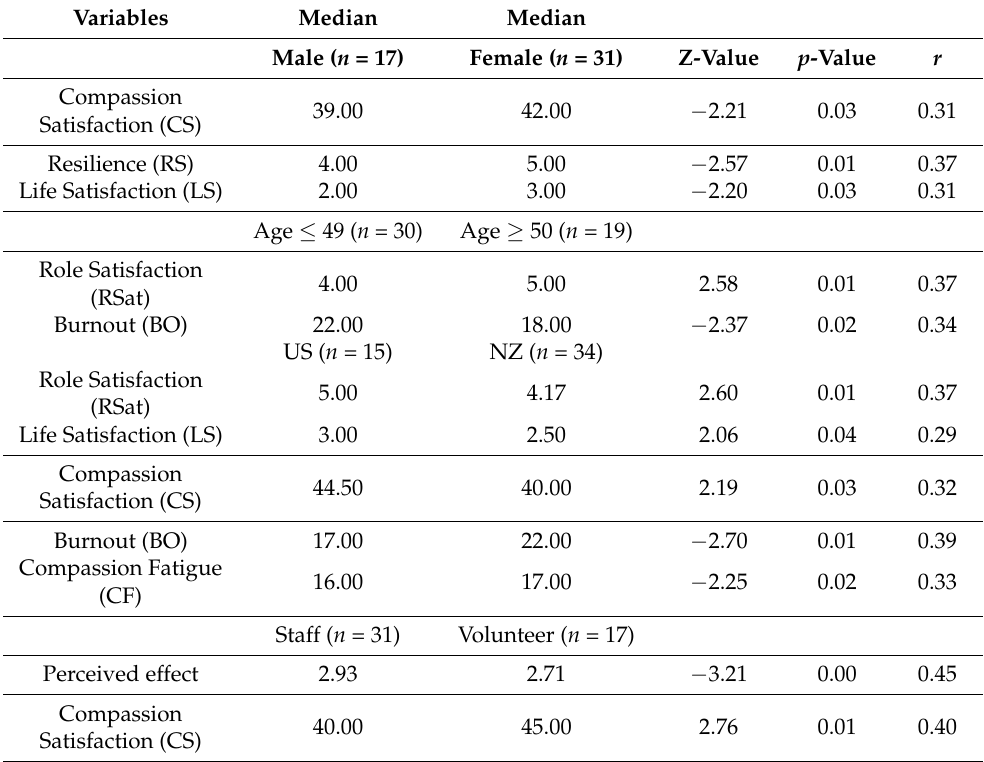
Table 6. Summary of differences among variables on Mann–Whitney